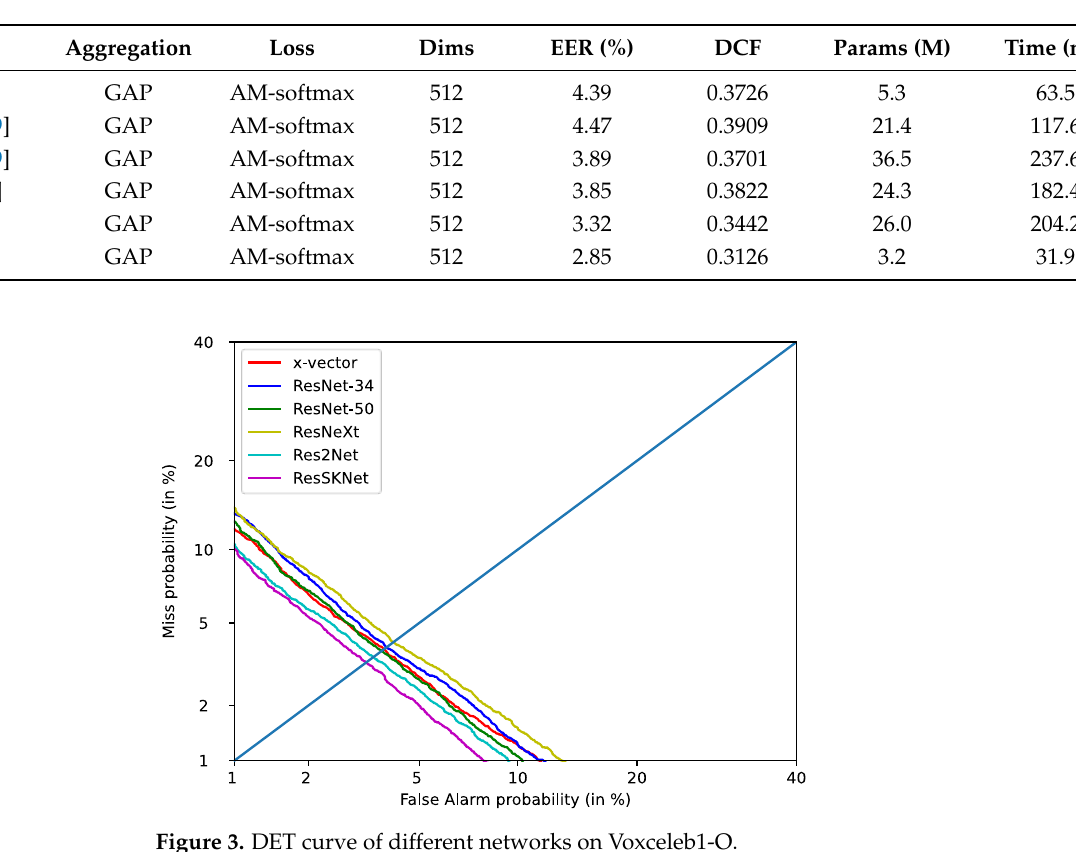
Table 4. Results of networks on Voxceleb1-O.